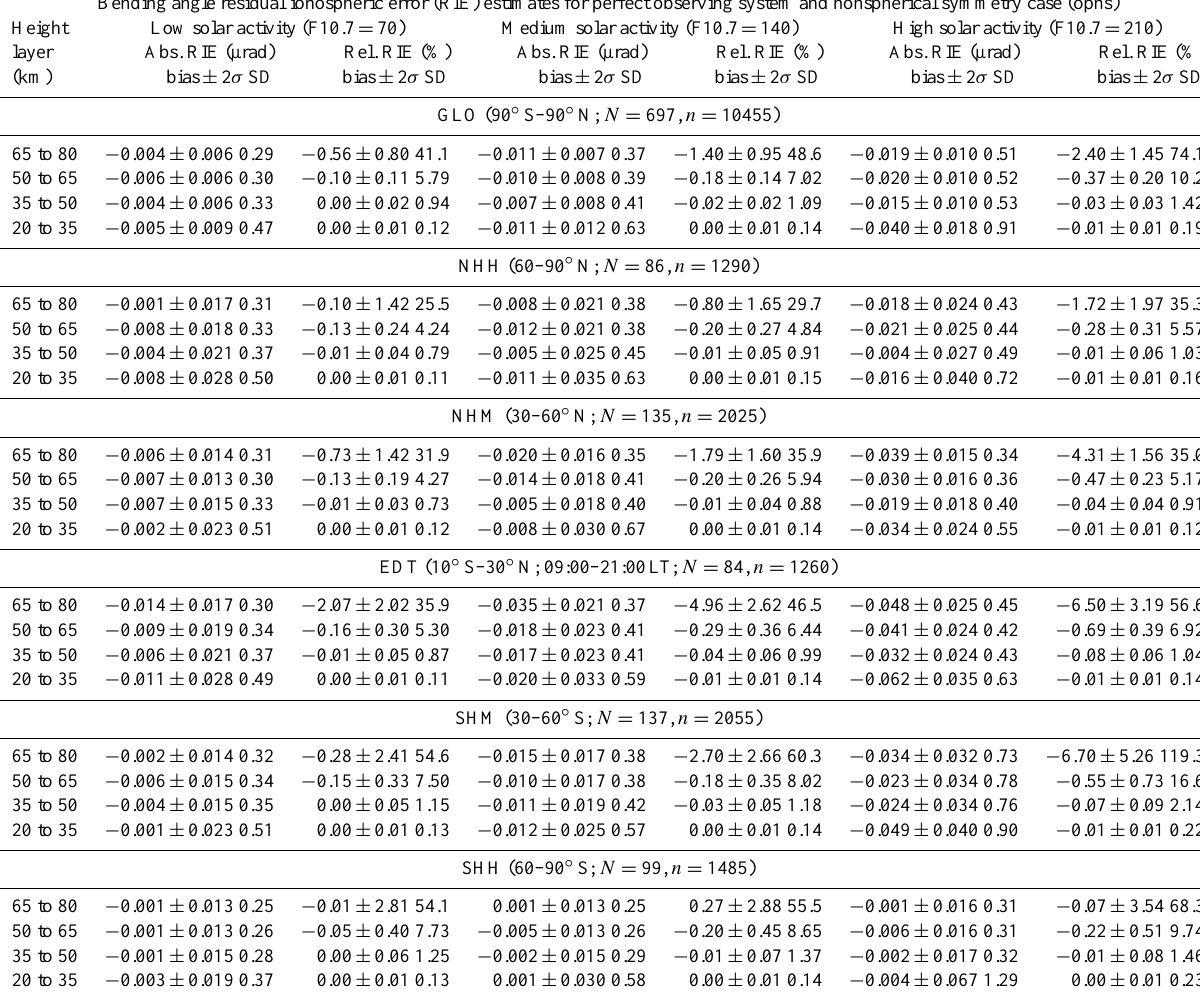
Table 5. Absolute and relative biases, including their 2 σ (95%) confidence ranges, and absolute and relative standard deviations of bending angle RIEs in the same layout as in Table 4 but for the opns